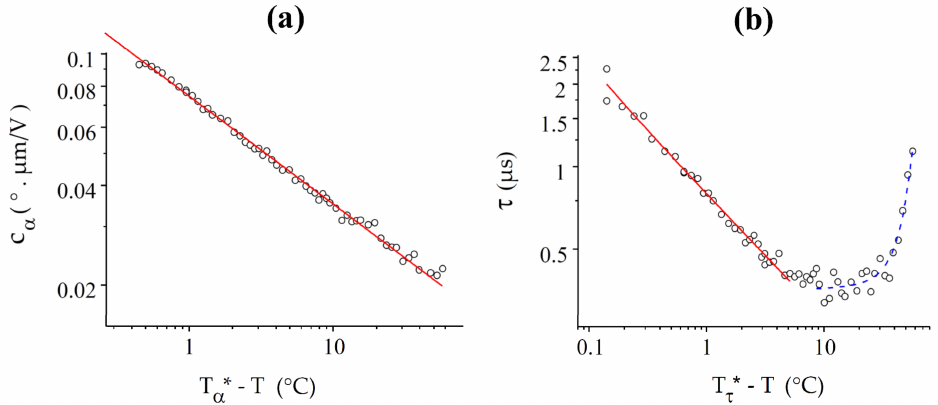
Figure 10. Best fits (red solid lines) of c α ( T ) and τ ( T ) with power laws for CB9CB: ( a ) For c α ( T ) , the fit c α ( T ) ∝ ( T α * − T ) − β α is good over the entire (>60 ◦ C) range under study, with T α * = 107.45 ◦ C and β α = 0.33; ( b ) The power law τ ( T ) ∝ ( T τ * − T ) − β τ , with T τ * = 100.14 ◦ C and β τ = 0.45 fits the curve well only in a range of about 5 ◦ C. As for CB7CB, at low temperature, the curve is well-fitted by an exponential growth law (blue dashed curve).